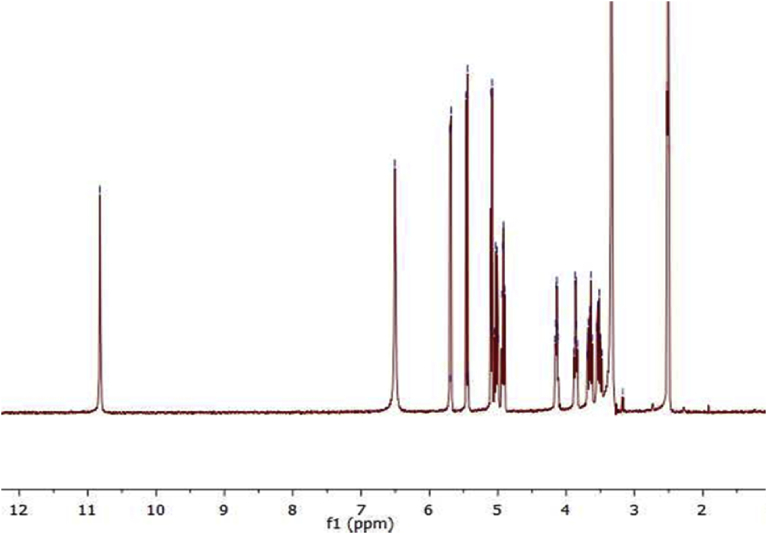
1H NMR of 8-bromoguanosine in DMSO.